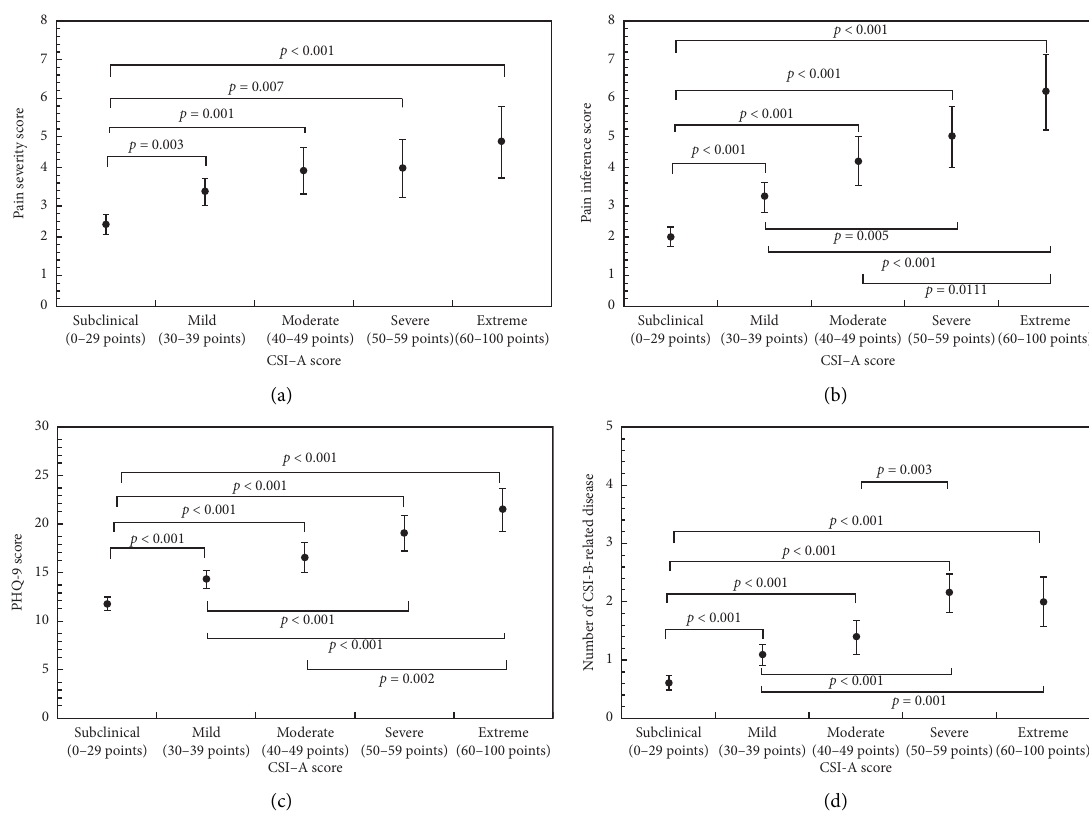
Figure 1: Relationship between clinical parameters and CSI-A score groups in the patients. Error bar indicates the 95% confidence interval. CSI: Central Sensitization Inventory; PHQ-9: Patient Health Questionnaire. using ANCOVA followed by post hoc comparison with the Bonferroni test. (a) and (b) were adjusted for sex, age, BMI, smoking, alcohol, caffeine and CSS-related diseases on CSI-B. (c) was adjusted for sex, age, BMI, smoking, alcohol, caffeine, CSS-related diseases on CSI-B, and BPI pain interference and severity score. (d) was adjusted for sex, age, BMI, smoking, alcohol, caffeine, PHQ-9 score, and BPI pain severity and interference score. (a) ( n � 459), (b) ( n � 474), (c) ( n � 452), and (d) ( n � 452). Table 4: Relationship between the number of CSS-related diseases on CSI-B and CSI-A scores. CSS-related diseases on CSI-B